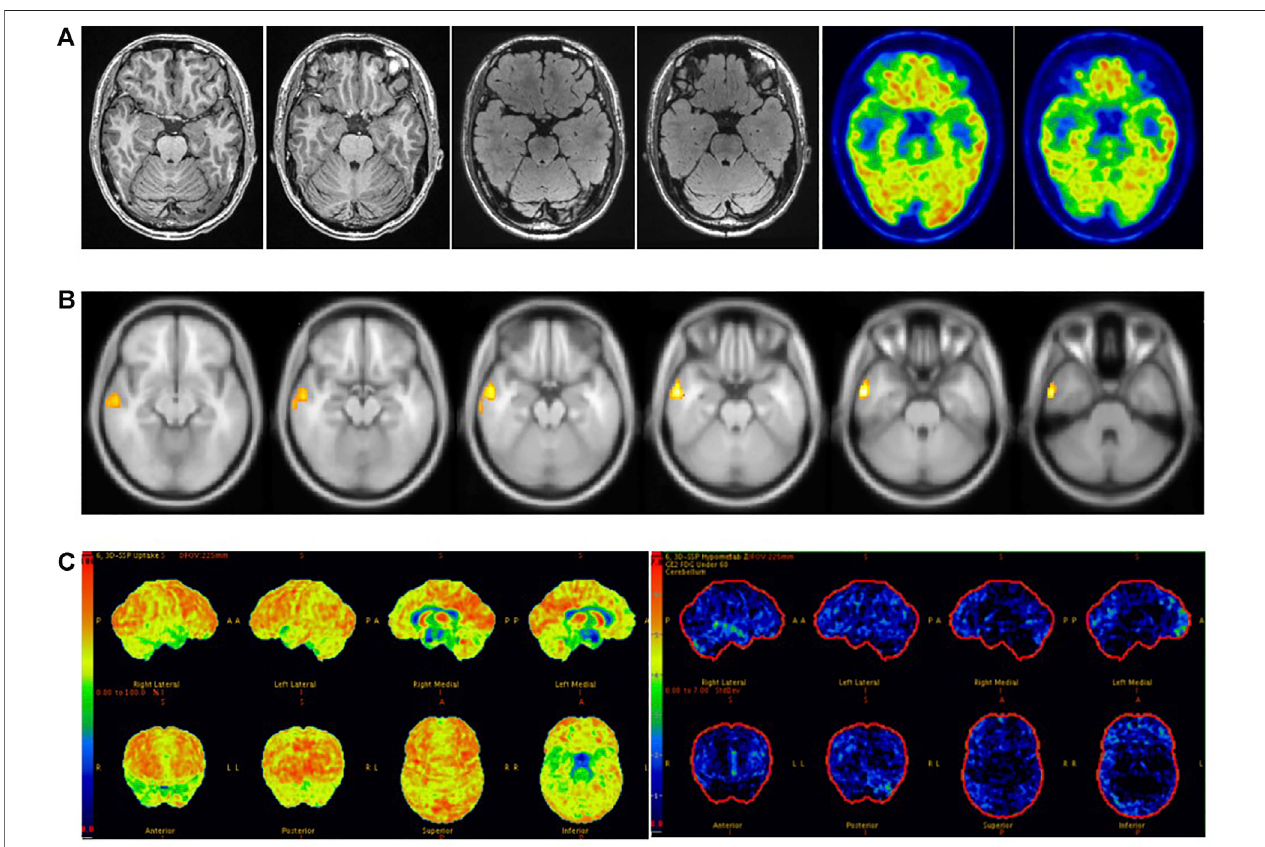
FIGURE 7 | Male,37 years old,right temporal lobeepilepsy. (A) Nostructural lesions causing seizureswerefound at 3.0 T epilepsy-protocol. 18 F-FDG PET obtained abnormal decreased metabolism in the right temporal lobe. (B) SPM showed decreased metabolism in right temporal lobe while p < 0.005 and K > 200. (C) Abnormal metabolism in the right temporal lobe was found by 3D-SSP. The right anterior temporal lobe was surgically resected and remained seizure-free for 2 years